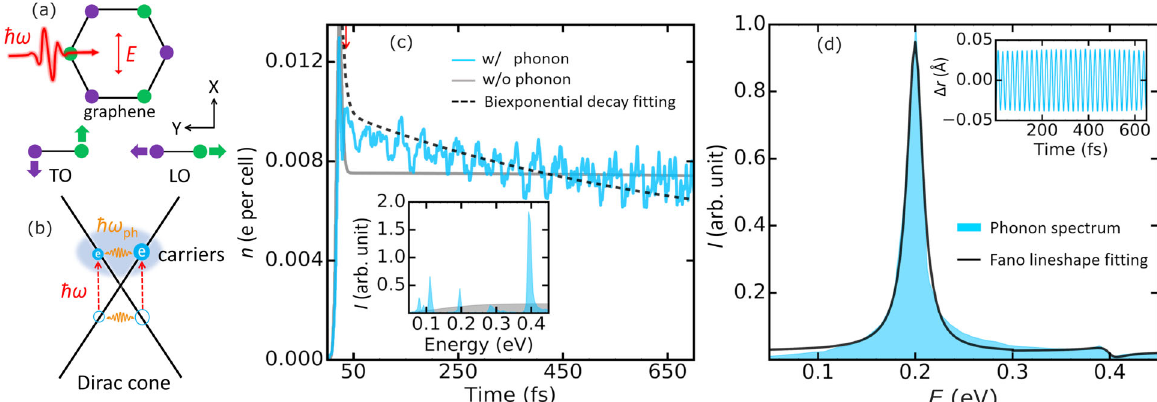
Fig. 1 Carrier and phonon dynamics in photoexcited graphene. a Schematic illustration showing laser illumination and the E 2g phonon@ Γ mode in graphene lattice. Red arrow shows the polarization direction of laser. b Illustration of photoexcitation process (red dash arrows) and EPC (orange spring arrows) in graphene. The fi lled and empty blue circles label photoexcited electrons and holes respectively. c Photocarrier population n ( t ) on the π * band as a function of time with (blue curve) and without (grey curve) phonons. The dashed black line is the fi tting with a biexponential decay. The red arrow labels the end of the pulse ( t ~30 fs). The inset shows the Fourier analysis on n ( t ) with (blue shade) and without (grey shade) phonons. d The phonon spectrum (blue shade). The solid black line is fi tting to the Fano lineshape. The inset shows the oscillation of carbon atom